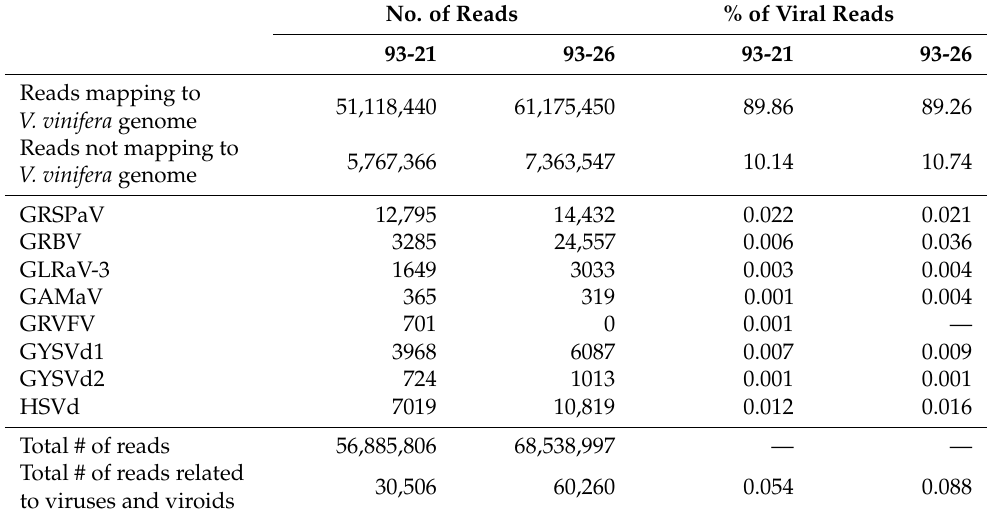
Table 4. Summary of HTS analysis of the virome of two Syrah vines that either exhibited a red canopy (93-21) or were without a red canopy (93-26) and their corresponding viruses/viroids. Grouping and abundance of sequence reads obtained from both samples were determined by mapping the sequence reads to the virus/viroid database using BLAT. Note: sample 93-26 had more sequence reads for all viruses and viroids that were detected, with the exception of GRVFV, which was